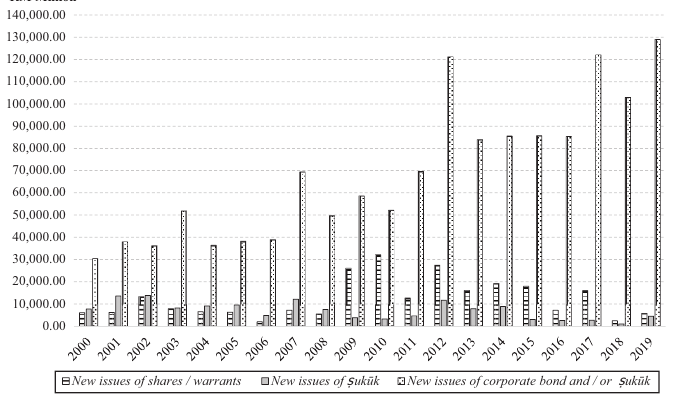
Figure 1. New issues of